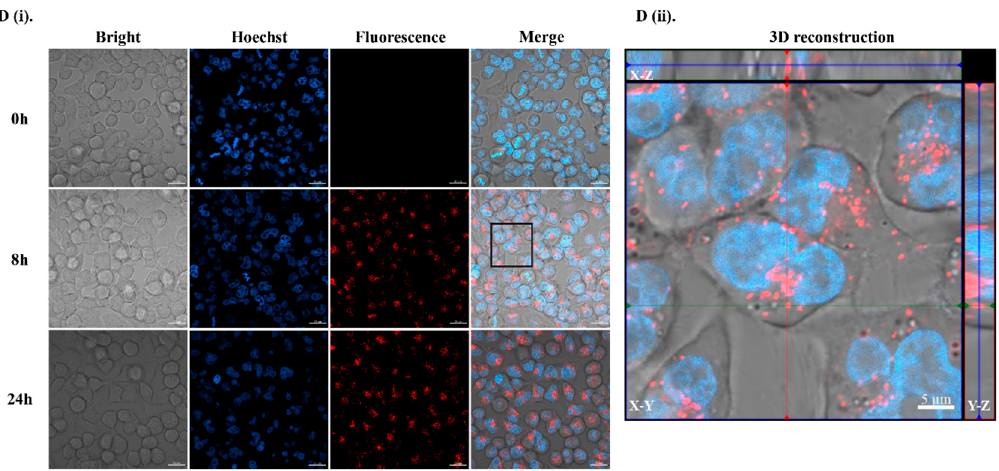
Figure 4. Predicted structure of peptide B11 and cell uptake analysis. ( A ) Amino acid sequence and primary structure of peptide B11. ( B ) The Schiffer–Edmundson helical wheel representation of peptide B11, showing the helical wheel projects and arrangement of amino acid residues counting from the amino ( N ) terminus. ( C ) Predicted 3D modeled structure of peptide B11. ( D ) Uptake of rhodamine-labeled B11 by HeLa cells. Cells were treated with rhodamine-labeled B11 at the indicated time points (0 h, 8 h, and 24 h), stained with Hoechst 33342, and then observed under a confocal microscope (scale bar = 20 μ m).